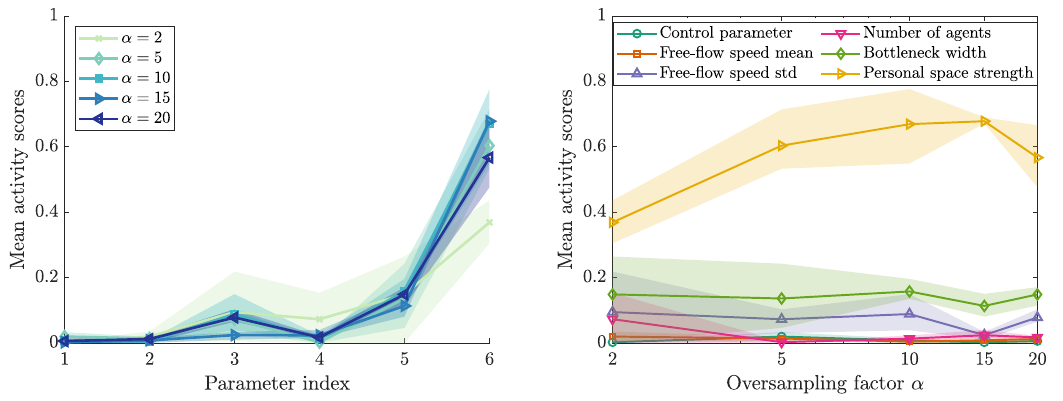
Figure 10. Activity scores from derivative-based method for the bottleneck scenario. For each value of the oversampling factor α , three runs are performed. The mean activity scores obtained for the runs (solid lines) are shown together with the extrema of the scores (patches). The parameter index is mapped as follows: 1—control parameter, 2—free-flow speed mean, 3—free-flow speed standard deviation, 4—number of agents, 5—bottleneck width, 6—personal space